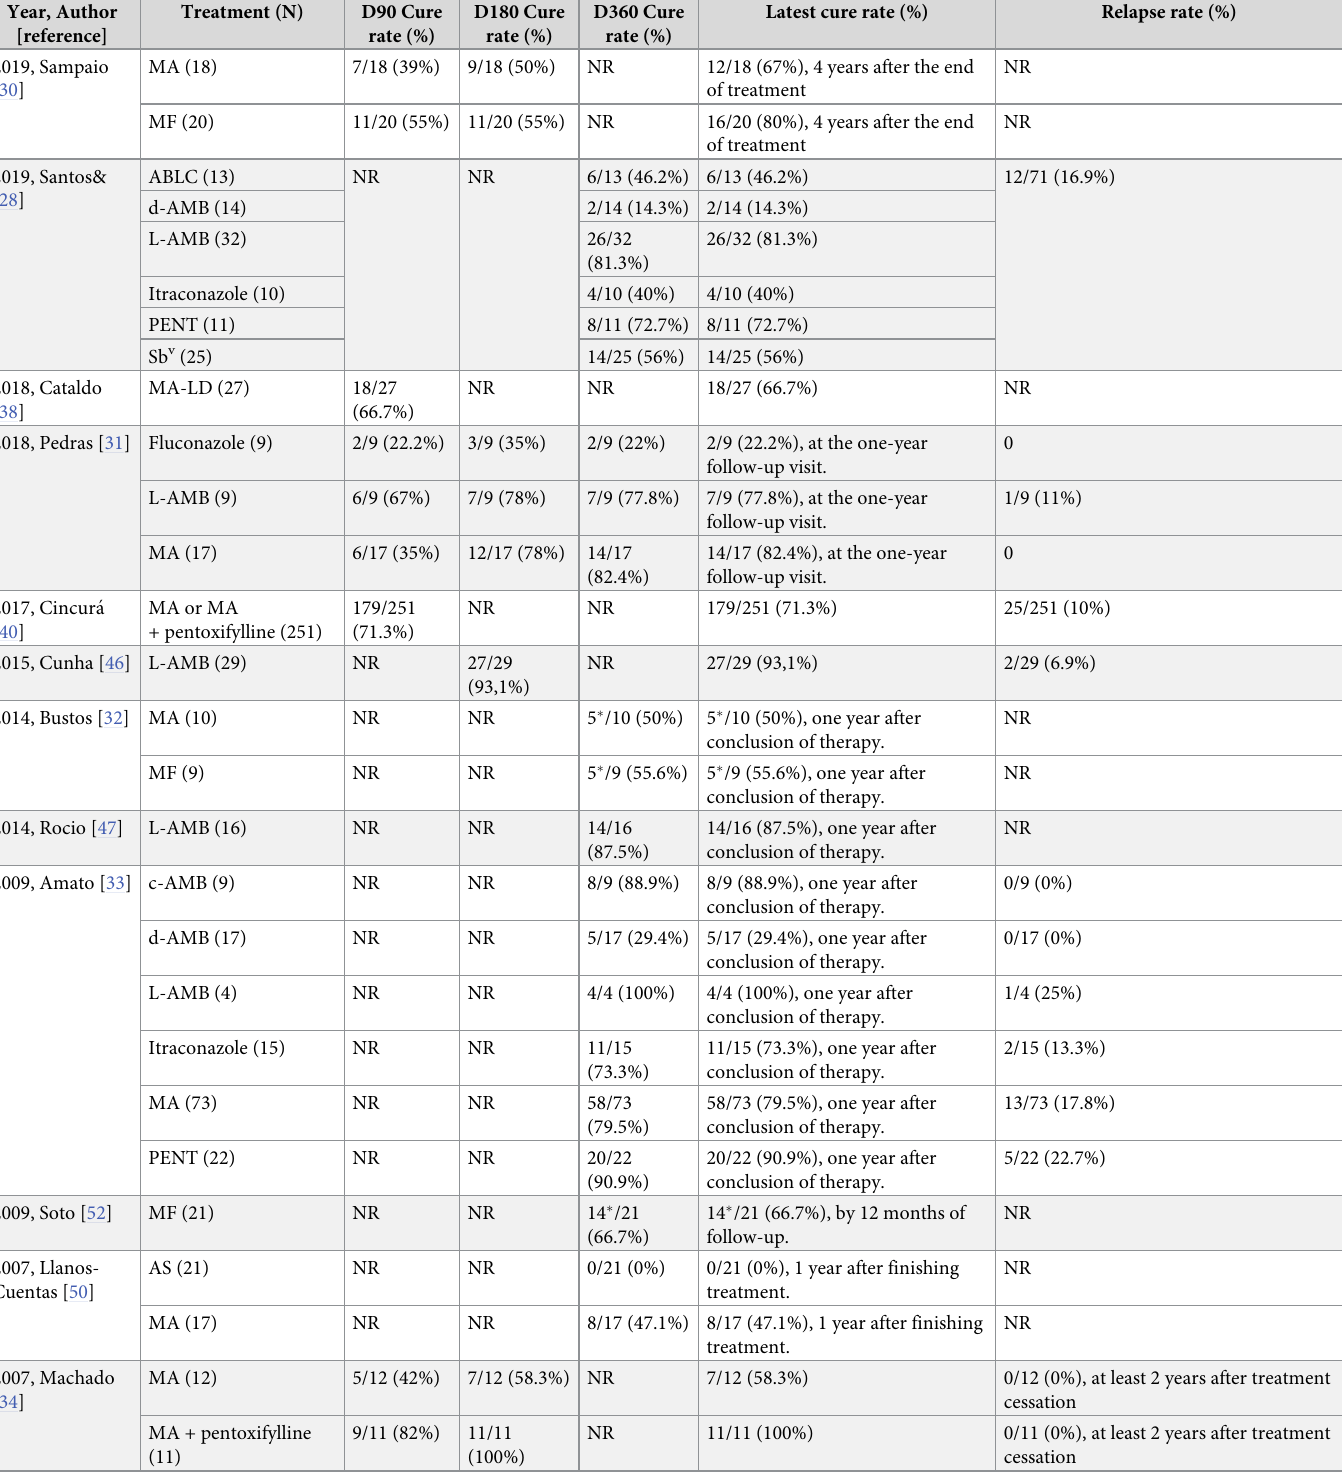
Table 3. Outcomes: cure and relapse rates according to the intent to treatment